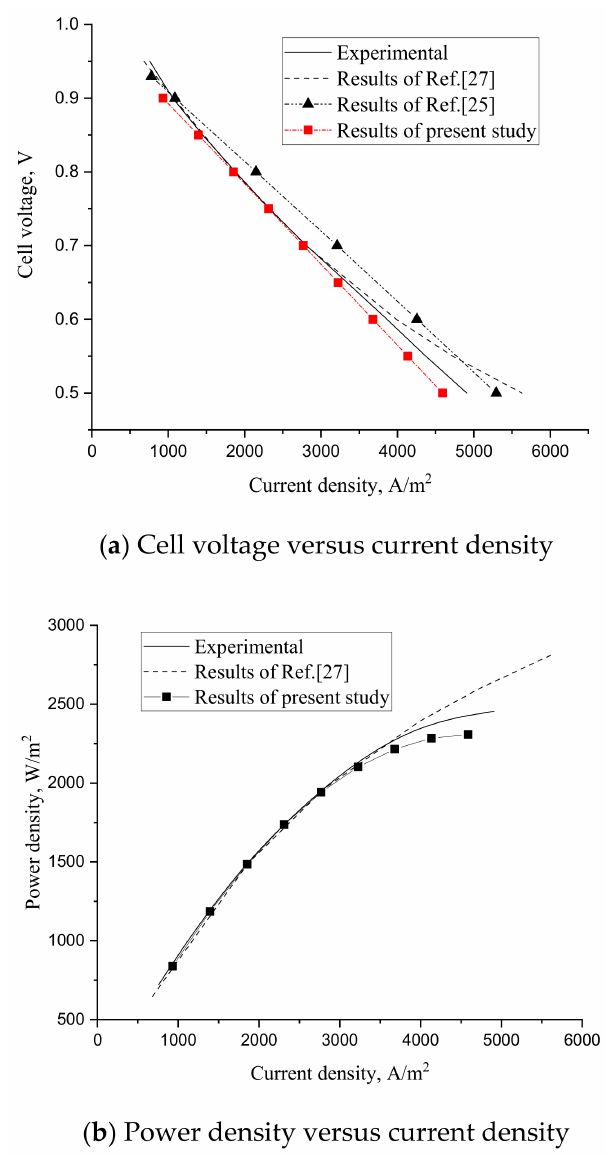
Figure 2. Comparison of the numerical results with those in [25,27]: ( a ) cell voltage versus current density and ( b ) power density versus current